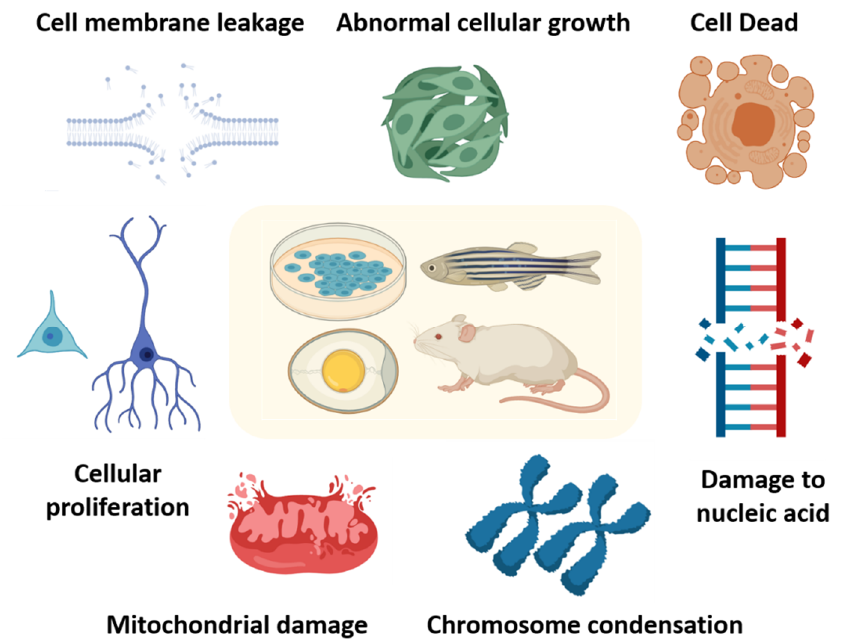
Figure 2. Potential toxicity e ff ects of magnetic nanoparticles (MNPs) collected from in vitro and in vivo experiments. The common strategies for risk assessment for MNPs, including cell culture, zebrafish, chicken and rodents are summarized in the central yellow panel. The potential toxicity e ff ects of MNPs have been categorized by mechanism, such as inhibition of cellular proliferation, temporary / absolute cell cycle cessation, DNA genotoxicity, damage of cellular components and aggregation to blocking of cell membranes on a cellular level. Some studies have reported MNPs’ toxicity e ff ects on a whole organism level and elaborated the interactions of MNPs inside the body (see the summary in Table 1 for detail literature citations).